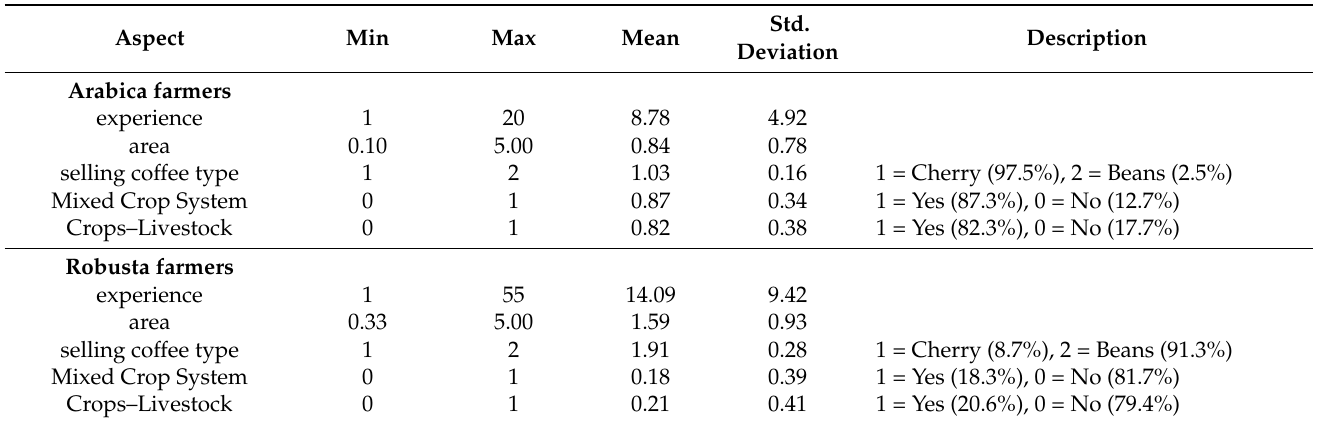
Table 5. Coffee farming system descriptions.